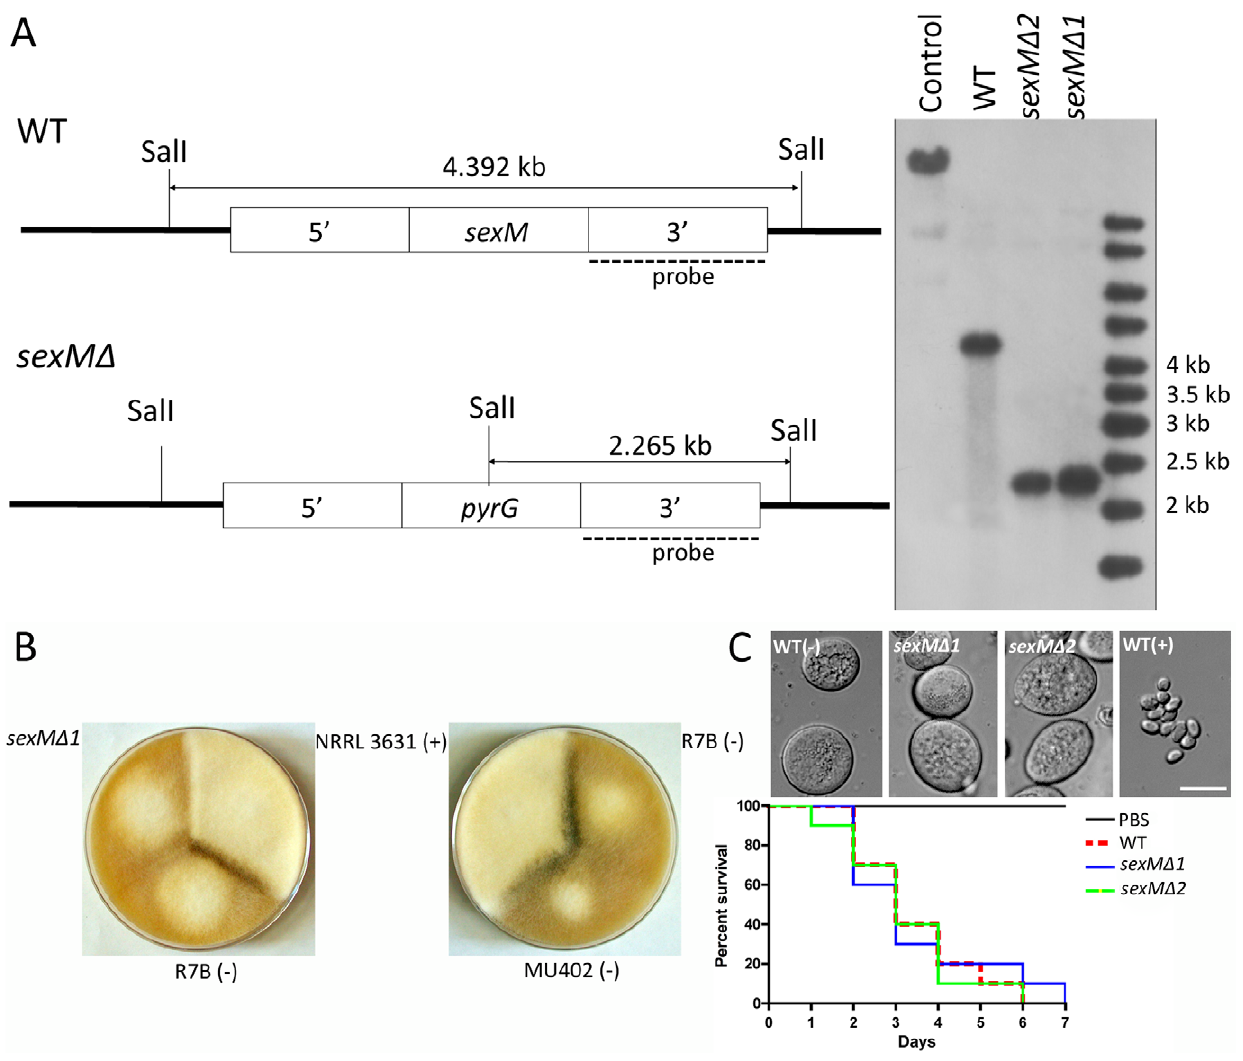
Figure 5. Disruption of the sexM gene and mating and virulence tests of the sexM mutants. (A) Southern blot analysis shows that the sexM gene was replaced with the pyrG gene resulting in disruption of the sexM gene in two transformants. The sexM probe corresponds to a 1.3-kb EcoRI fragment of the 3 9 region of sexM . (B) Two sexM mutants [MU423 ( sexM D 1 ) and MU424 ( sexM D 2 )] are sterile in mating assays with ( + ) or ( 2 ) strains (see also Figure 3S). The parental MU402 strain is a pyrG leuA double mutant. (C) The sexM mutants do not display differences in spore size or virulence in the wax moth host. See Figure 3S for additional PCR validation of the sexM mutant strains.